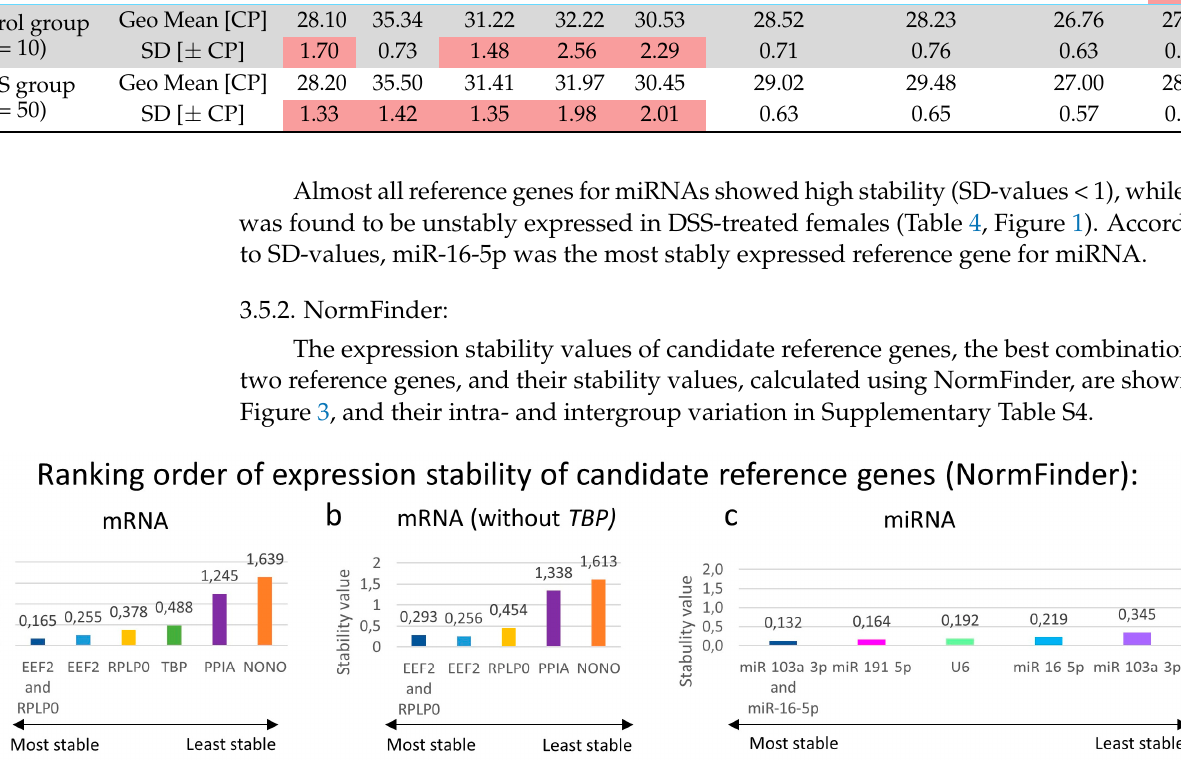
Figure 3. Expression stability of candidate reference genes in archived FFPE colon samples of control and DSS-treated C57BL6/JOlaHsd mice, calculated with NormFinder. The lower the stability values, the better the stability of reference genes. ( a ) Stability values of mRNA candidate reference genes and best combination of two mRNA reference genes in FFPE samples with determined TBP (n = 101) and ( b ) without TBP (n = 117). ( c ) Stability values of miRNA candidate reference genes and best combination of two miRNA reference genes in all FFPE samples (n = 117).